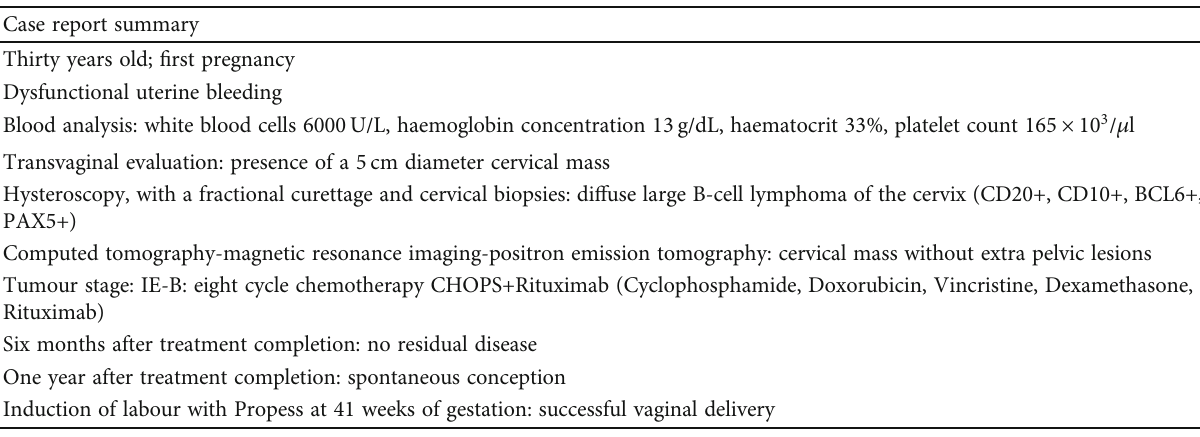
Table 1: Case report summary.